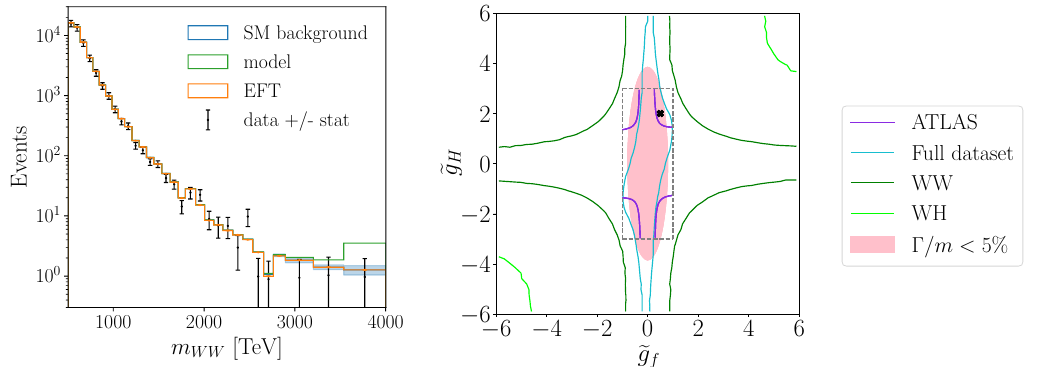
= 4TeV, ˜ g = 2, ˜ g = 0.5 (shown by a star V H f = 4TeV and profiled over the matching V